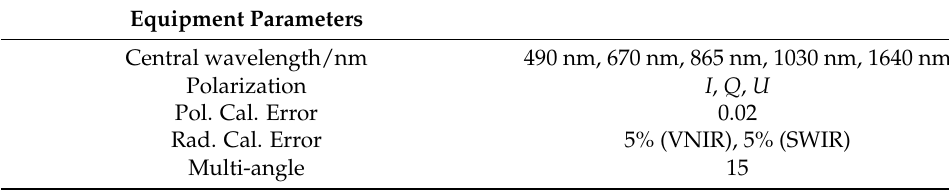
Table A1. Basic characteristics of sensor.